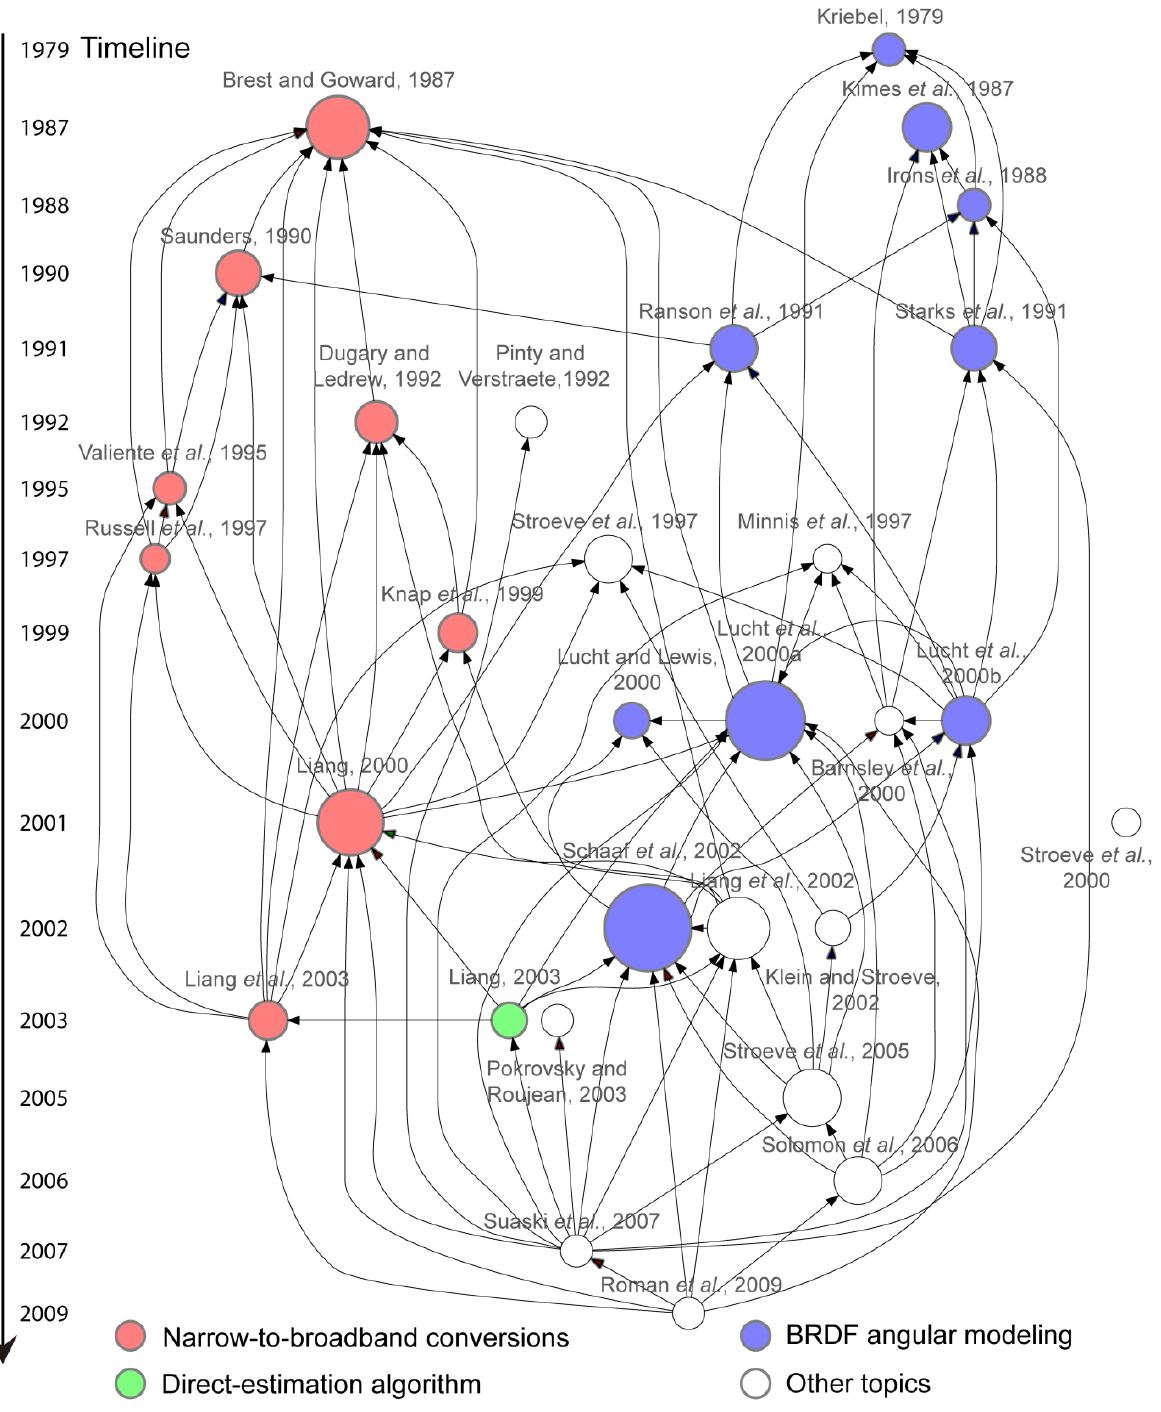
Figure 3. Citation relationship figure for mapping surface broadband albedo with satellite data, where the radius of the circle stands for the total citations of its corresponding literature; the vertical axis stands for the timeline (the published year for each study), the horizontal axis stands for the similarity of papers; the arrow pointing to the circle stands for its corresponding paper, which is cited by the consequent papers; the color of circle indicates the themes of articles: narrow-to-broadband conversions (red), BRDF angular modeling (blue), direct-estimation algorithm (green) and other topics